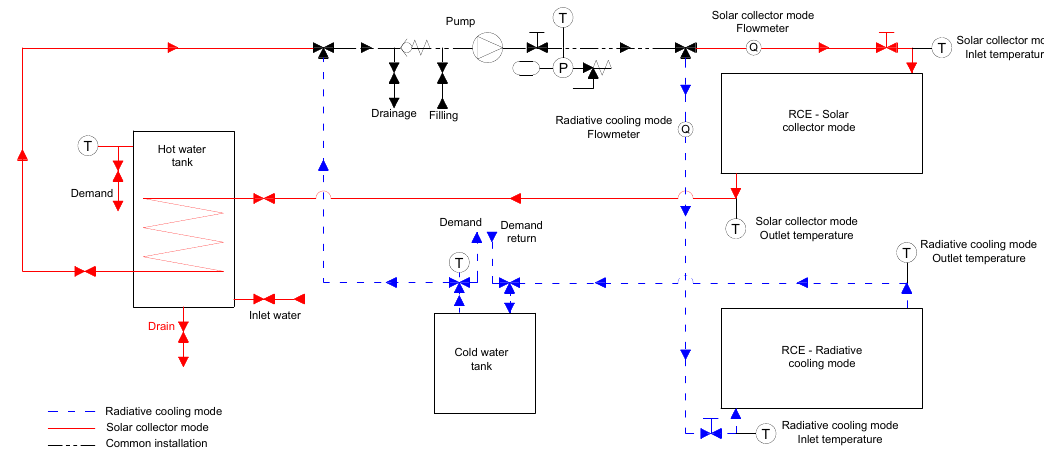
Figure 2. Sketch of the experimental setup.